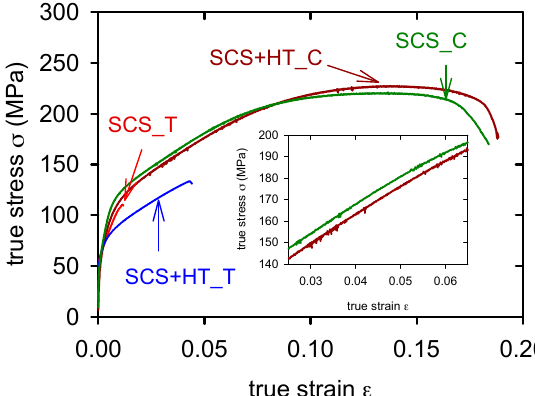
Figure 7. True stress–true strain curves obtained for SCL alloy in tension (T) and compression (C). Due to very low ductility of the as cast alloy in tension, the curve is introduced in the insert.